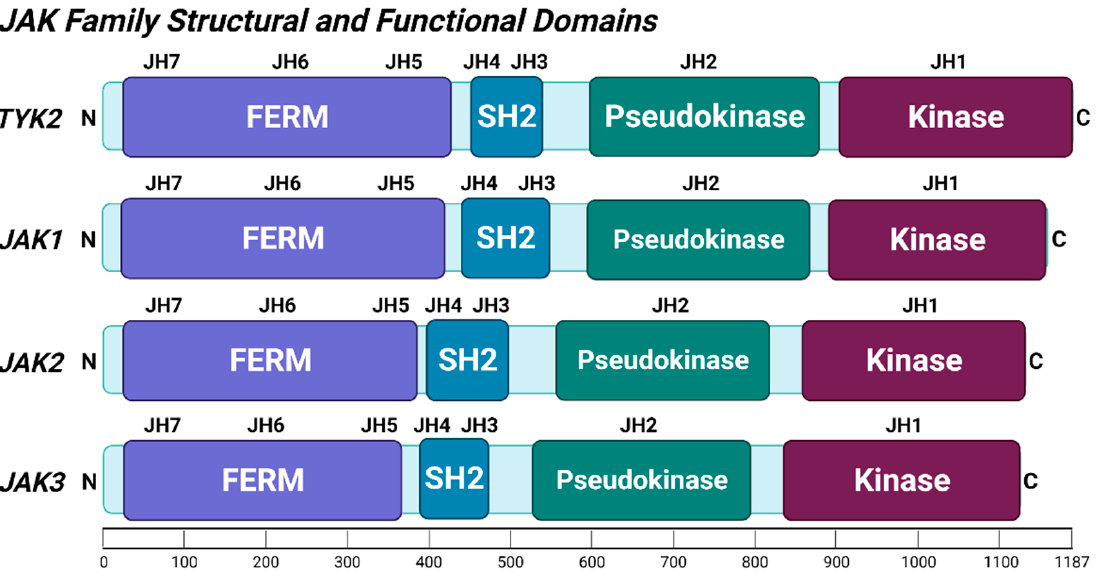
Figure 1. Schematic diagram of the structural and functional domains of the TYK2 and JAK1-3 proteins. TYK2/JAK1-3 consist of four structural domains (FERM, SH2, pseudokinase, and kinase domains) that overlap with seven JAK homology (JH1-7) domains. Scale bar shows amino acid (aa) range (0-1187 aa) from the N-terminus to the C-terminus. Illustration created with BioRender.com (accessed 5 August, 2021).